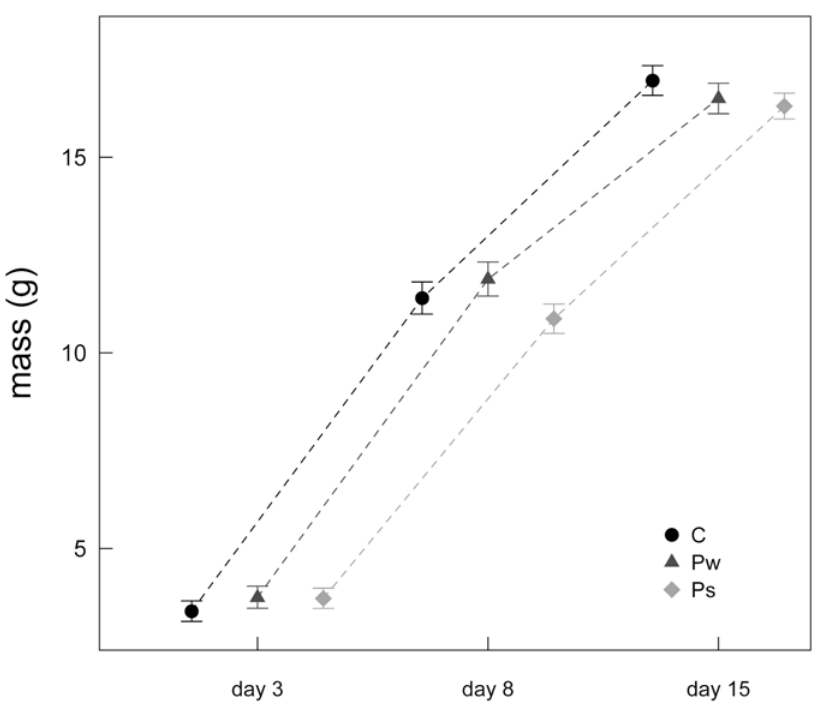
Fig 4. Nestling mass (mean ± SE) on three measurement days. The shape of growth curves differed significantly according to the interaction between the treatments ( P < 0.001). Growth was slower from day 3 to day 8 in the Ps group and from day 8 to day 15 in the Pw group. C = mothers exposed to control treatment; Ps = mothers exposed to the sparrowhawk predator treatment; Pw = mothers exposed to the weasel predator